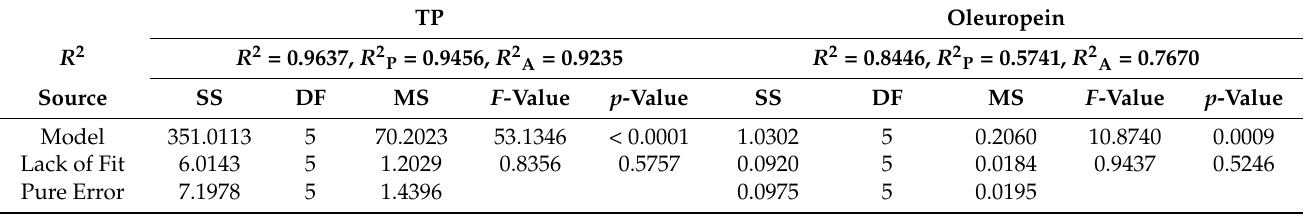
Table 2. Analysis of variance (ANOVA) for the fitted model polynomial equations. TP Oleuropein